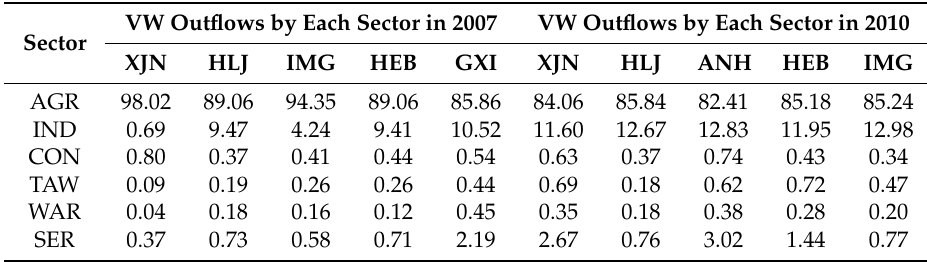
Table 1. Sectoral proportions of VW flowing out of the five regions with the largest net outflows for the years, 2007 and 2010 (units: %).